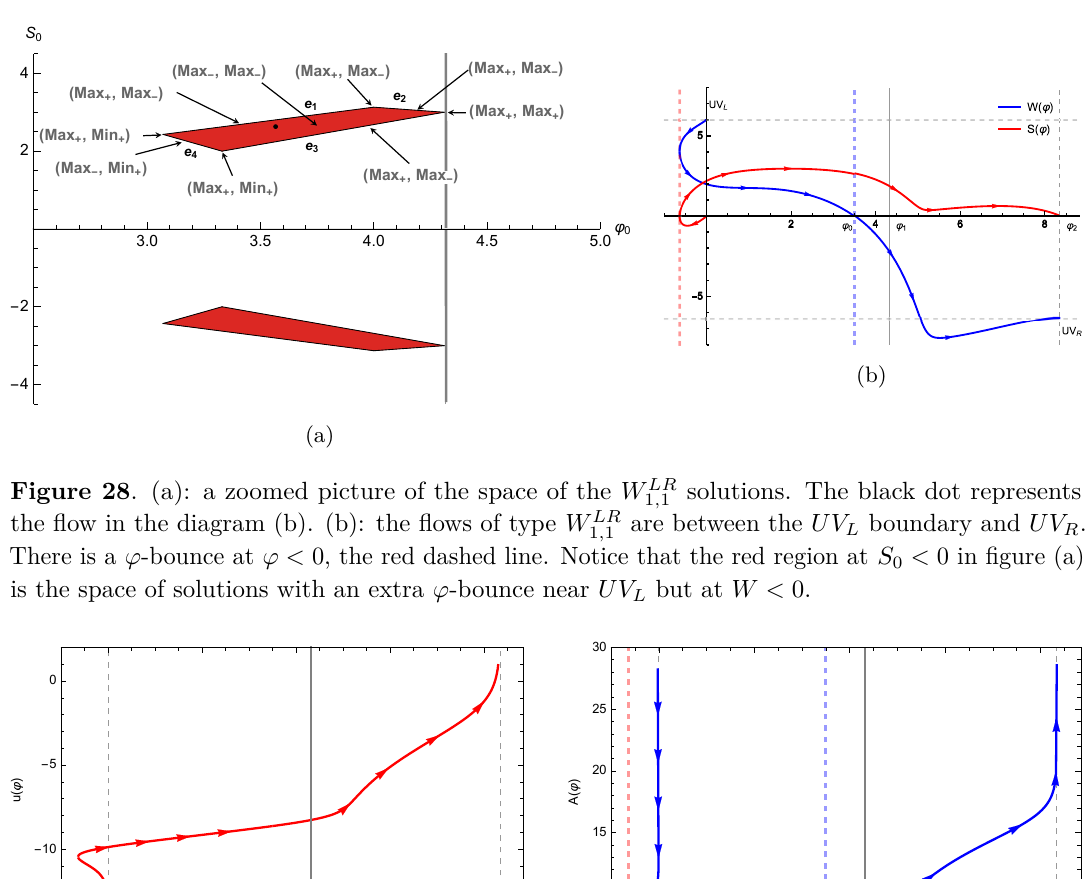
Figure 29 . (a): the holographic coordinate at UV L boundary tends to −∞ and at UV R to + ∞ . (b): the scale factor has an A-bounce at ϕ = 3 . 5 , the blue dashed line. A ϕ -bounce occurs at 0 ϕ = − 0 . 64 , the red dashed